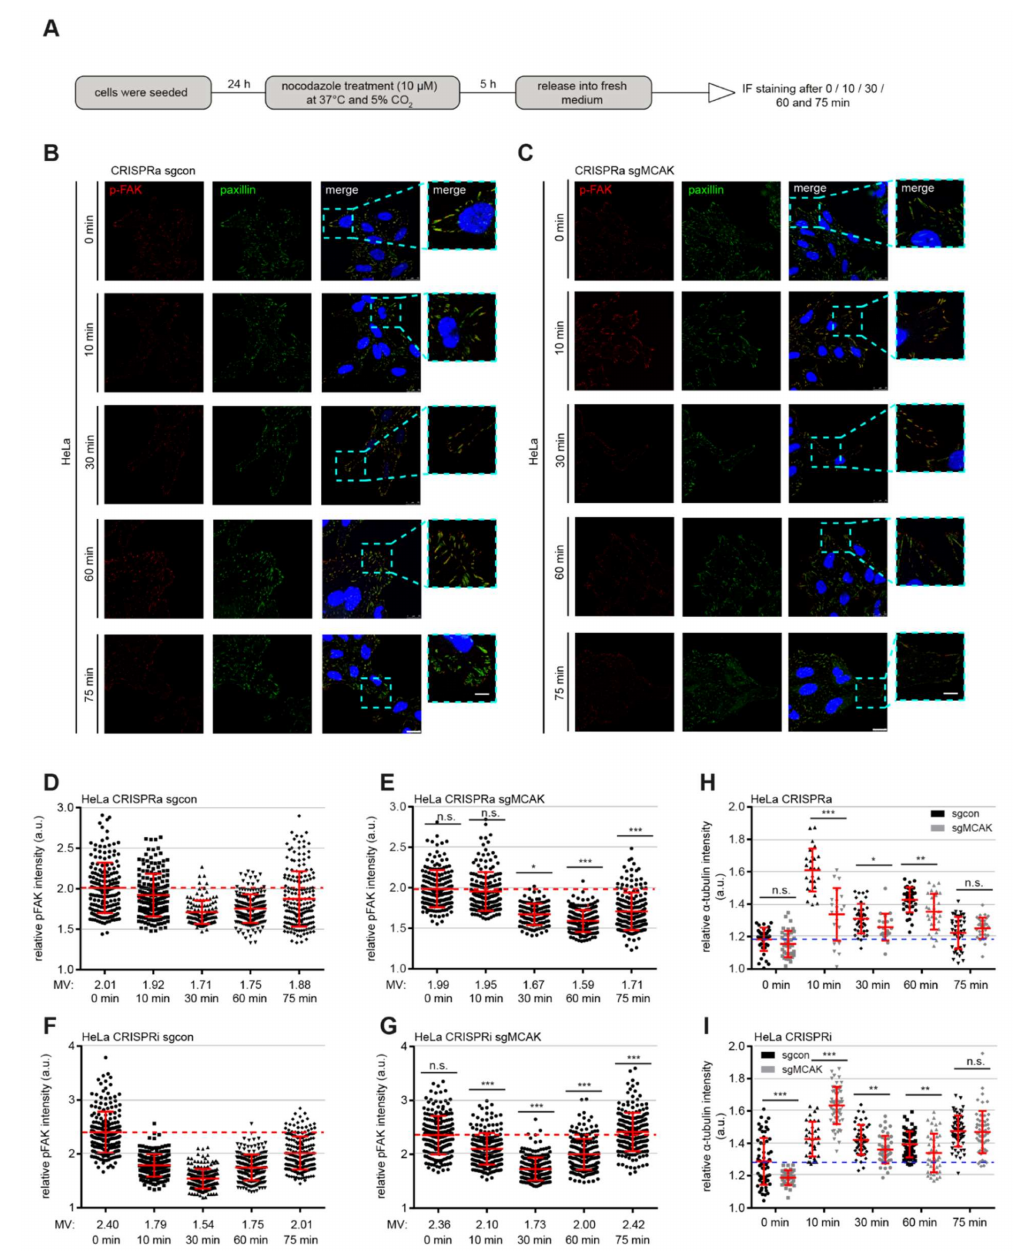
Figure 6. CRISPRi/a cells display a delayed MT-induced FA disassembly and assembly. ( A ) Schedule of nocodazole washout experiment. HeLa CRISPRi/a cells were treated with 10 µ M nocodazole for 5 h and released into fresh medium for indicated time points. ( B , C ) HeLa CRISPRa sgcon ( B ) and CRISPRa sgMCAK ( C ) cells were stained for p-FAK (red), and paxillin (green). Representatives of FA disassembly and assembly are shown. Scale: 25 µ m, inset scale: 12.5 µ m. ( D–G ) Quantification of the mean fluorescence intensity of p-FAK (red) per FA (90 FAs per condition and experiment) in HeLa CRISPRa ( D , E ) and CRISPRi ( F , G ) cells. The results are based on three independent experiments and presented as scatter plots showing mean ± SEM, a.u., arbitrary units. ( H , I ) Quantification of the MT repolymerization by measuring the mean fluorescence intensity of α -tubulin in whole cells (30 cells per condition) in HeLa CRISPRa ( H ) and CRISPRi ( I ) cells. The results are based on three independent experiments and presented as bar graphs showing mean ± SEM. Unpaired Mann–Whitney U test was used. * p < 0.05, ** p < 0.01, and *** p < 0.001. Abbreviation: n.s.: not